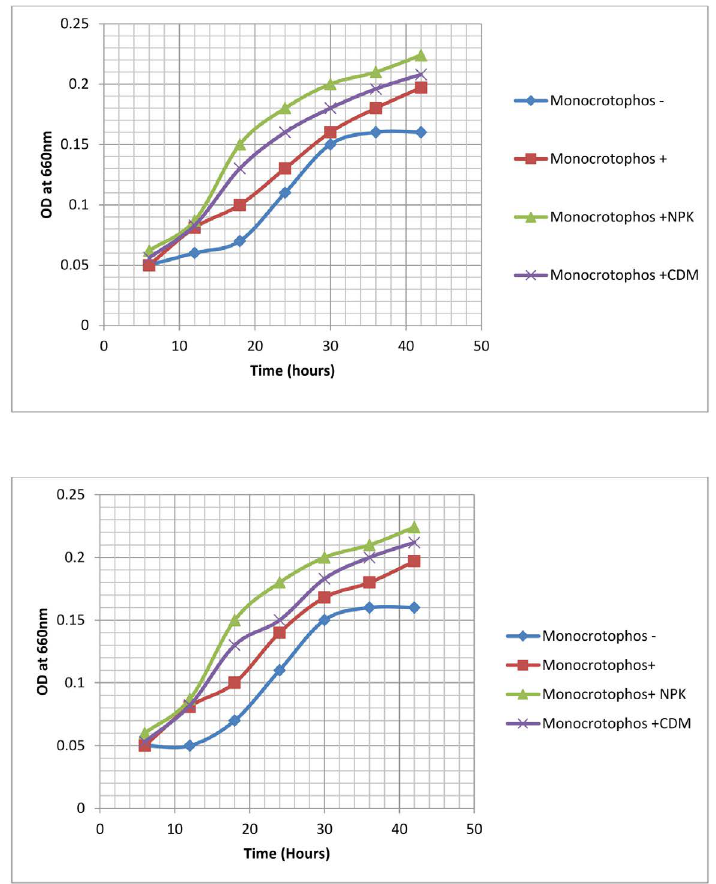
Fig. 3. Degradation potential of individual Isolates and Consortium for Monocrotophos.